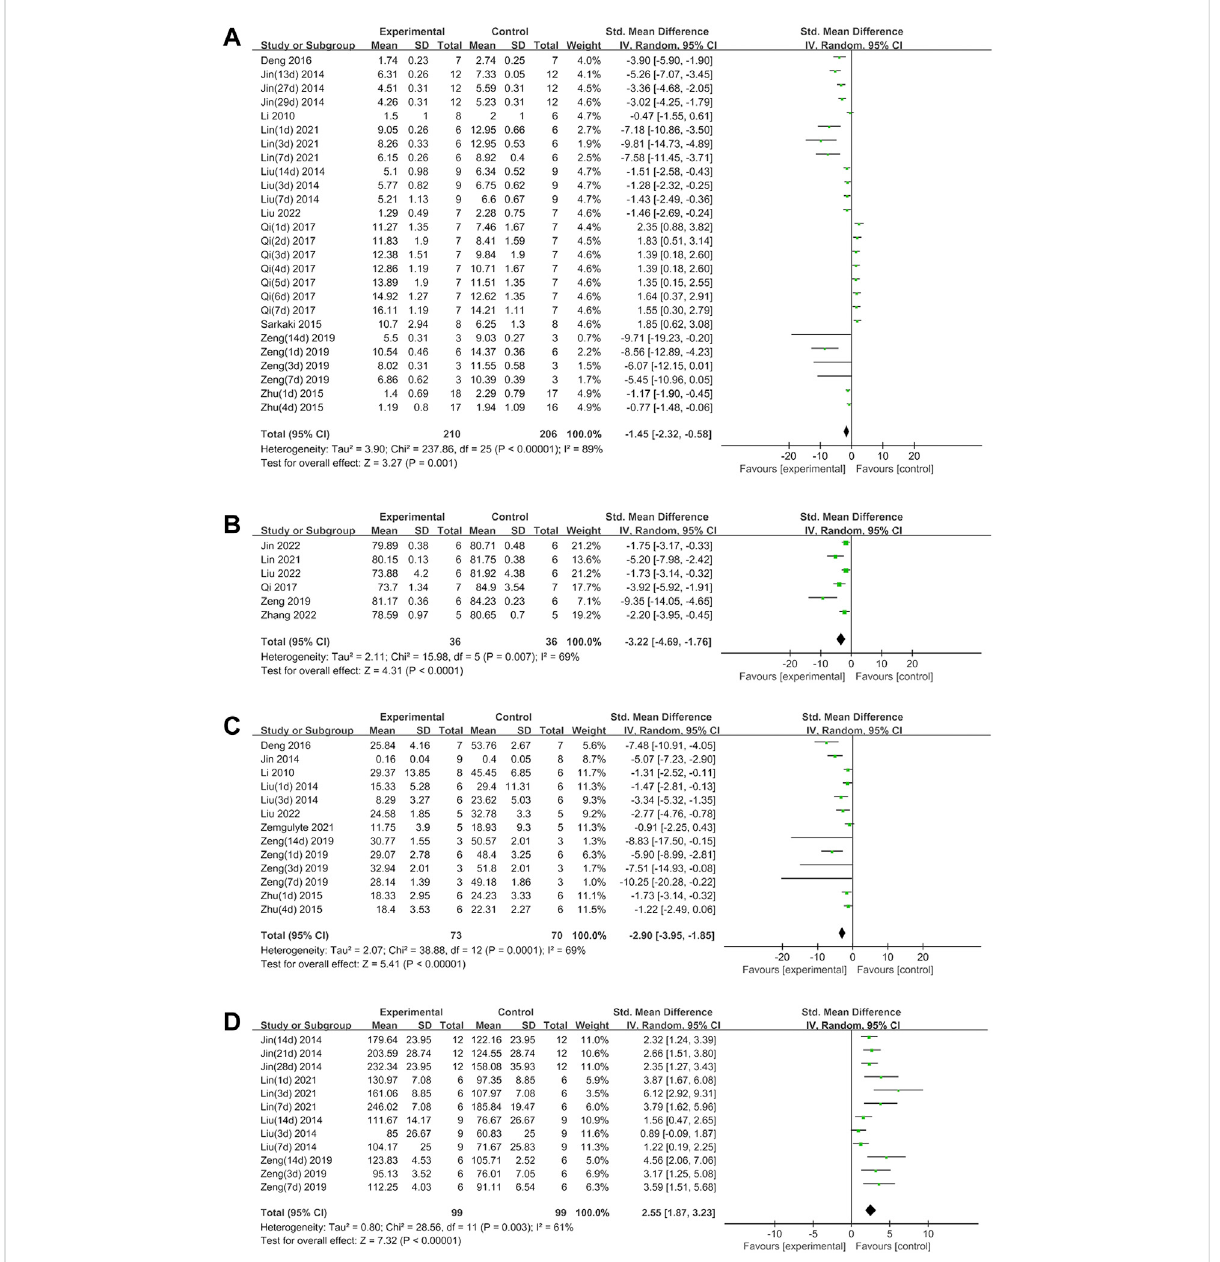
FIGURE 2 (A) Forest plot analyzing the effect of metformin treatment of NS. (B) Forest plot analyzing the effect of metformin treatment of the brain water content. (C) Forest plotanalyzing theeffect ofmetformin treatment of theinfarct size. (D) Forest plot analyzing theeffect of metformin treatmentof the rotarod